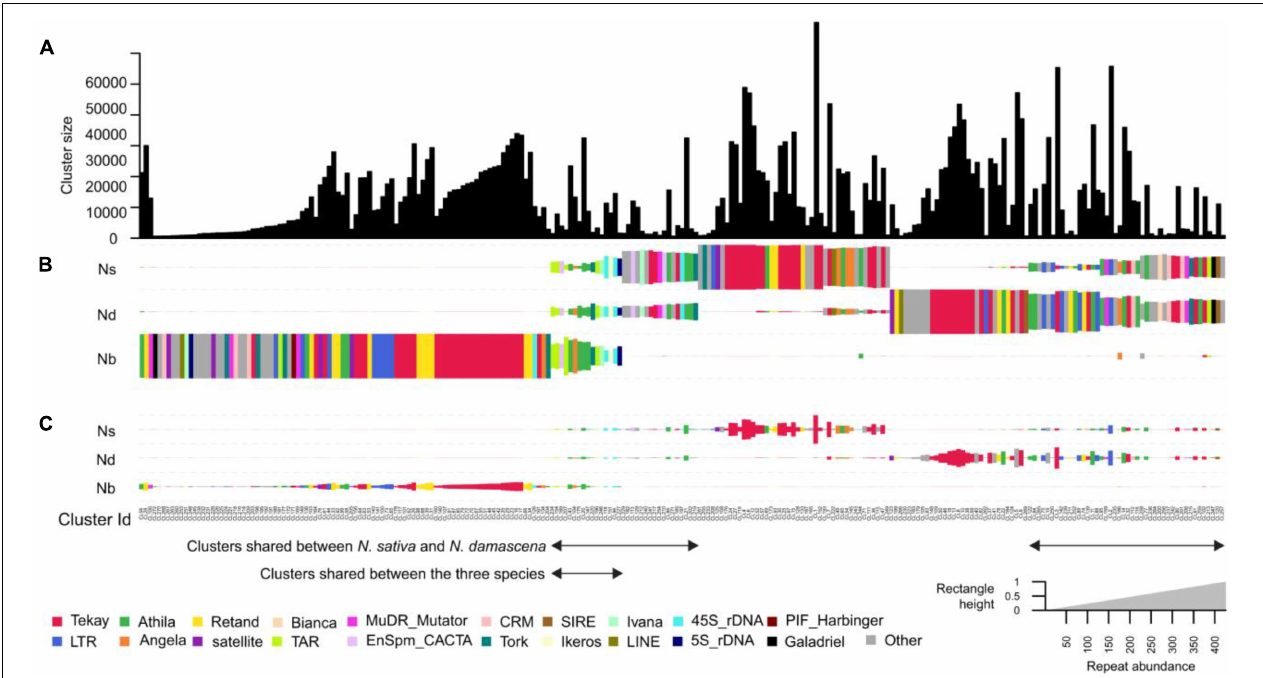
FIGURE 3 | Comparative analysis of genome repetitive composition among three Nigella species. (A) Bar plot of N. damascena, N. sativa and N. bucharica showing the sizes (numbers of reads) of individual clusters. (B) Rectangle size is proportional to the number of reads in a cluster for each species. Clusters were sorted by using hierarchical clustering and the rectangles are colored based on their cluster annotation. (C) The size of the rectangles in (B) was normalized based on the genome size of analyzed species. Species codes: ND, N. damascena ; NS, N. sativa ; Nb, N. bucharica .